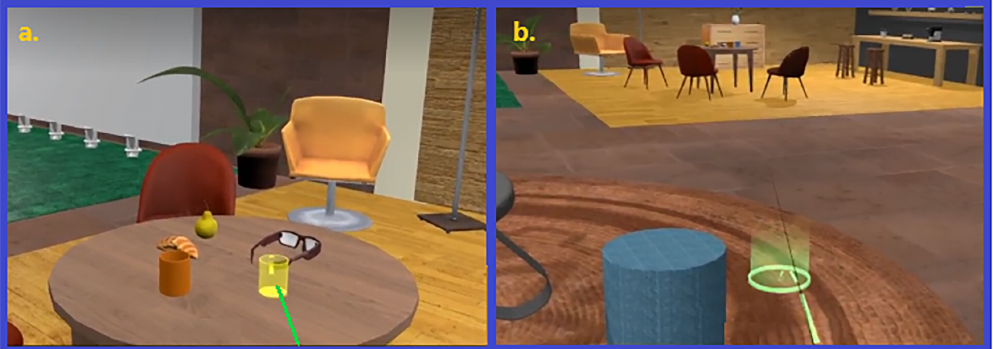
Figure 5. Screenshots showing different parts of the panel for interactions: ( a , d ) selecting the “I am ready” and “Answering the phone” buttons by the user; ( b , e ) visualization of the task tab; ( c , f ) visualization of the item tab.